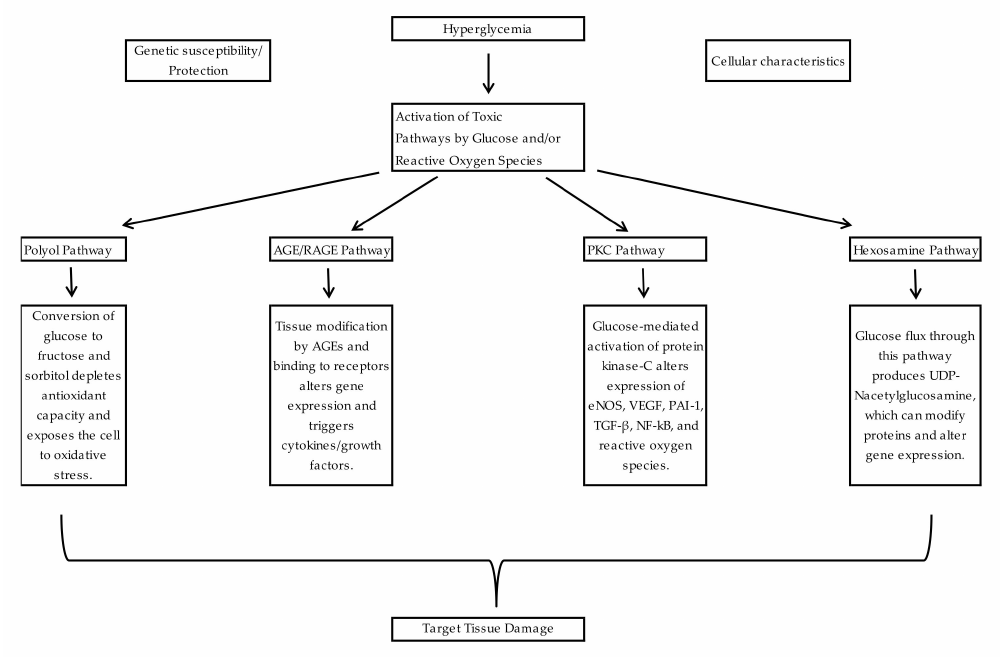
Figure 2. Toxic pathways linking blood glucose levels to tissue damage in susceptible persons, adapted from Brannick et al. [3]; AGE, advanced glycosylation end products; eNOS, endothelial nitric oxide synthase; NF- κβ , nuclear factor- κβ ; PAI-1, plasminogen activator inhibitor-1; PKC, protein kinase C; RAGE, receptor for AGE; TGF- β , transforming growth factor- β ; UDP, uridine diphosphate; VEGF, vascular endothelial growth